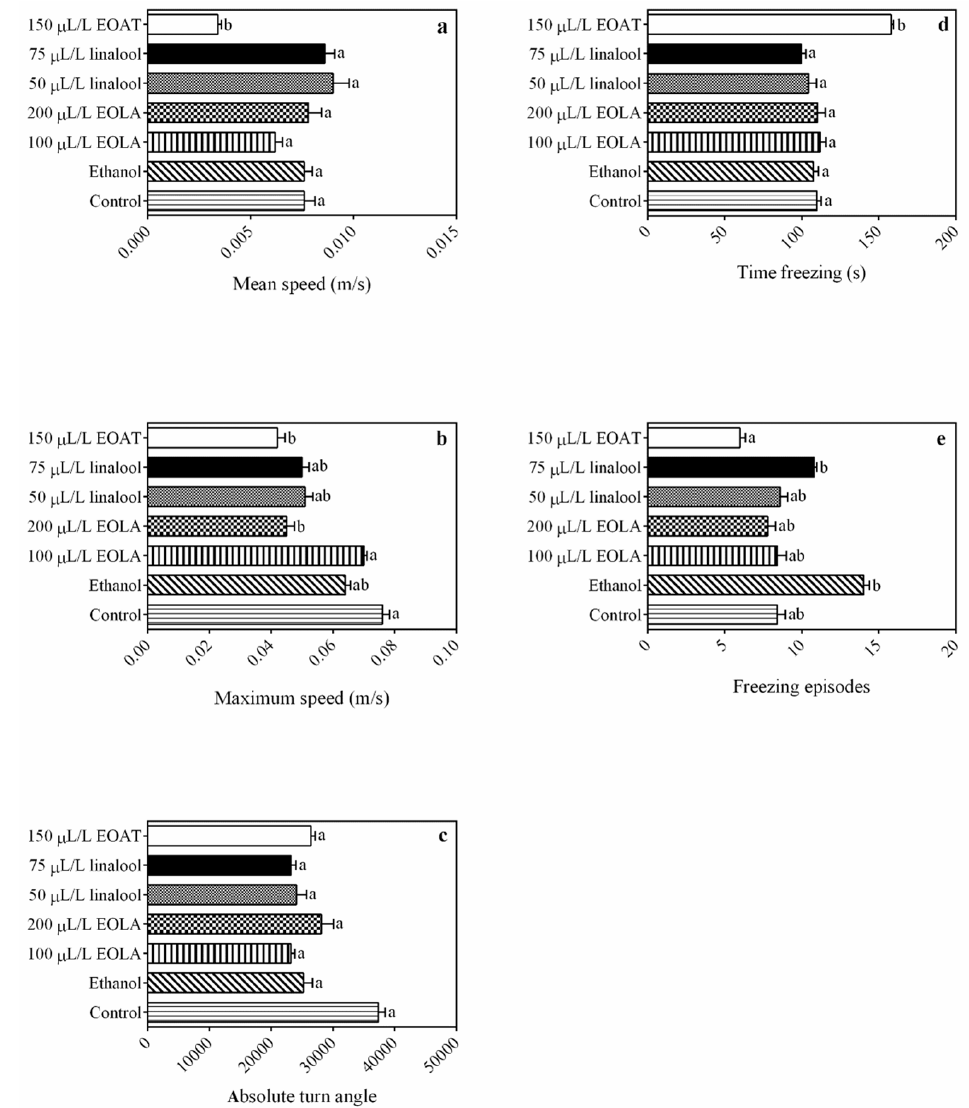
Figure 2. Locomotor parameters and comparison between immobility periods observed in H. bonariensis groups during behavioral trial. Mean speed ( a ). Maximum speed ( b ). Absolute turning angle ( c ). Time of freezing ( d ). Freezing episodes ( e ). Different letters on the right side of the bars indicate significant differences between anesthetic concentrations ( p < 0.05; by one-way ANOVA followed by Tukey’s or Kruskal–Wallis tests; n = 5 per group).